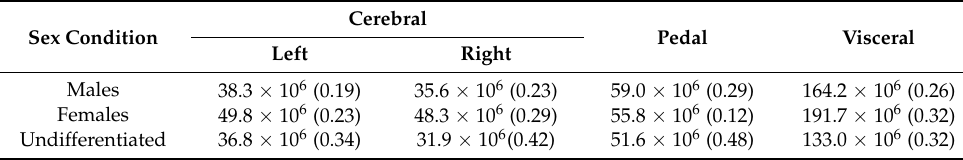
Table 2. Total volumes ( µ m 3 ) of the cerebral, pedal and visceral ganglia of S. plana